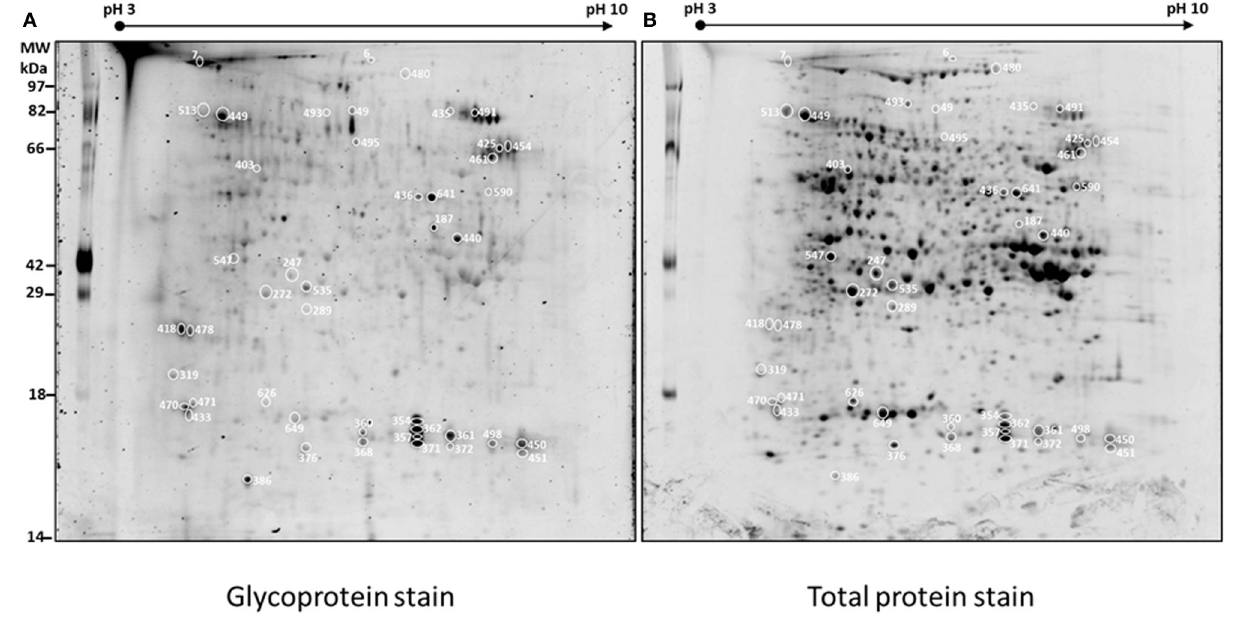
numbers selected for protein identification by LC-MS/MS are marked with a circle. Numbers on various spots in each gel refer to the #s shown in the 1st column, Table 1